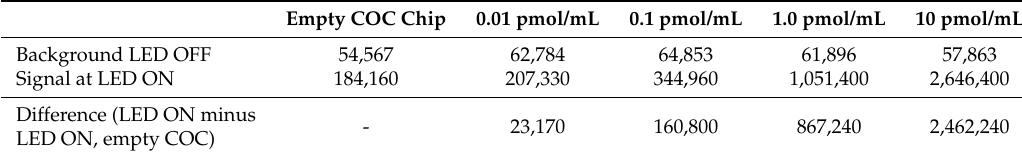
Table 2. Average fluorescence intensities, in photon counting per 100ms, at different concentrations of surface fluorescence tagged capture probes. Sets of 49 measurements each concentration.